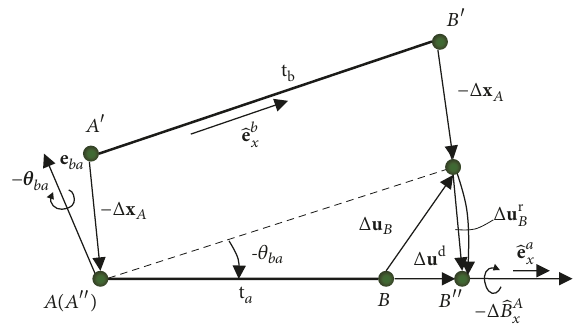
Figure 5: Reverse movement of space beam